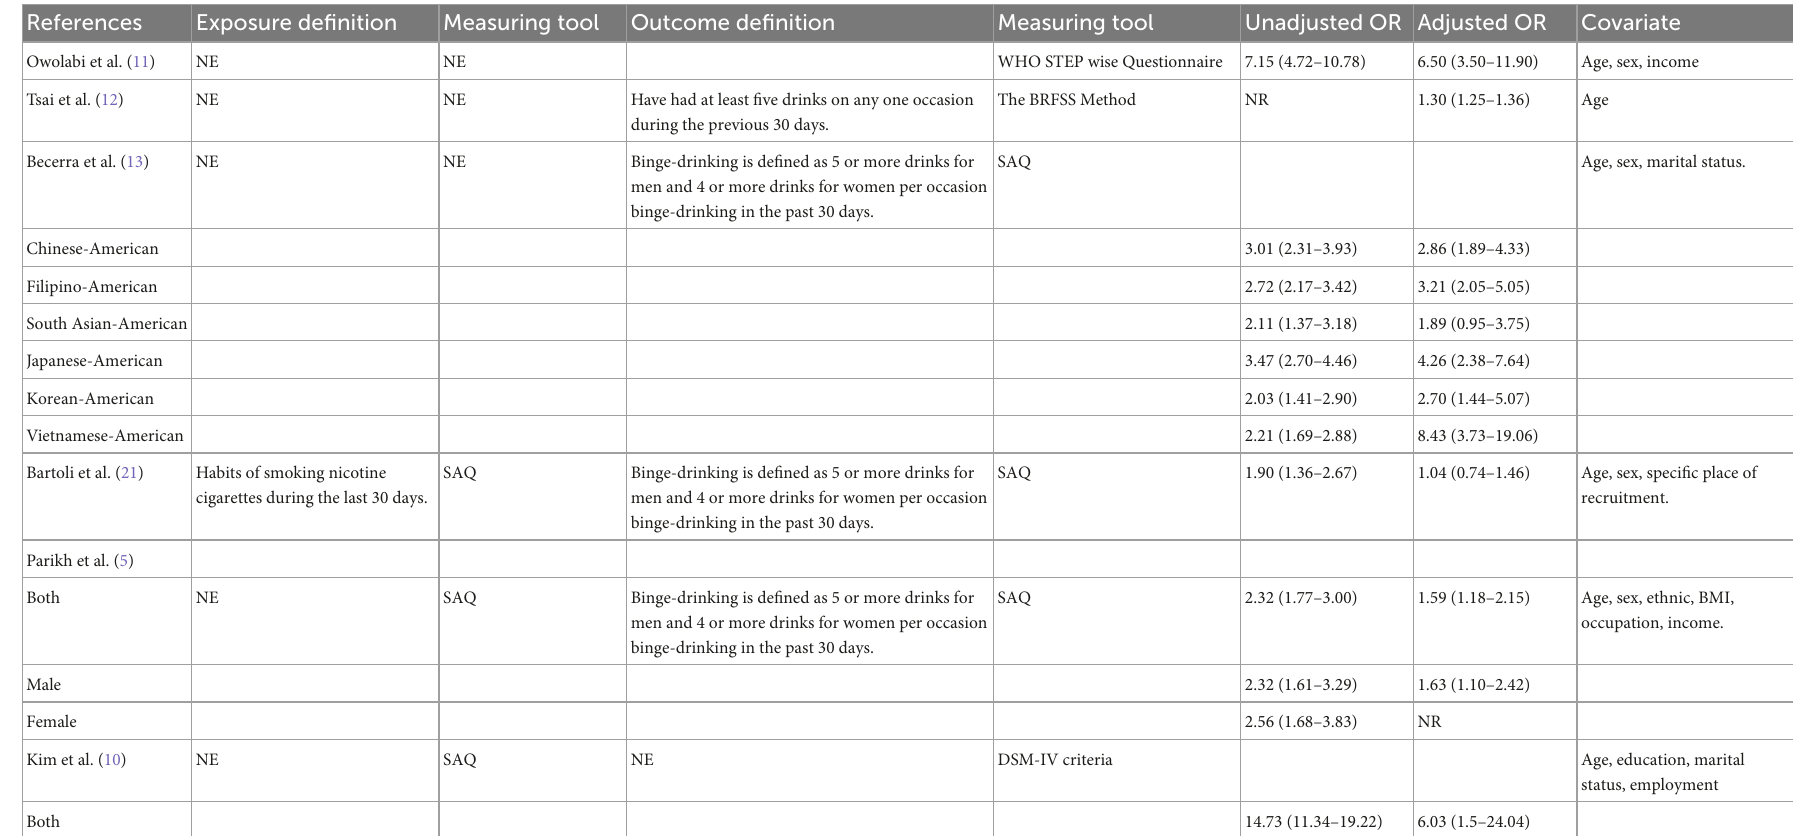
TABLE 2 Description of current smoking and binge-drinking definition, report unadjusted and adjusted odds ratios with 95% confidence intervals and description